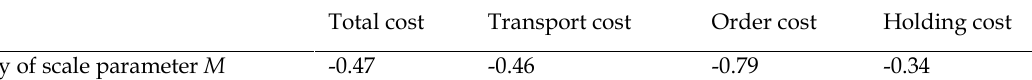
Table 4. Estimated scale parameters for different cost types